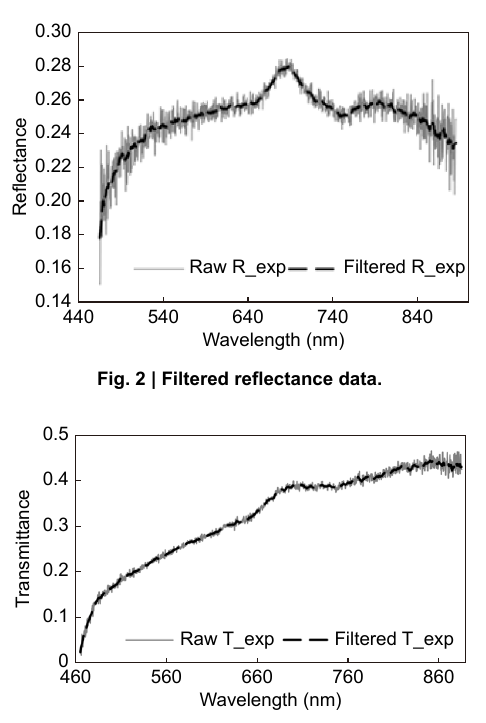
Fig. 3 | Filtered transmittance